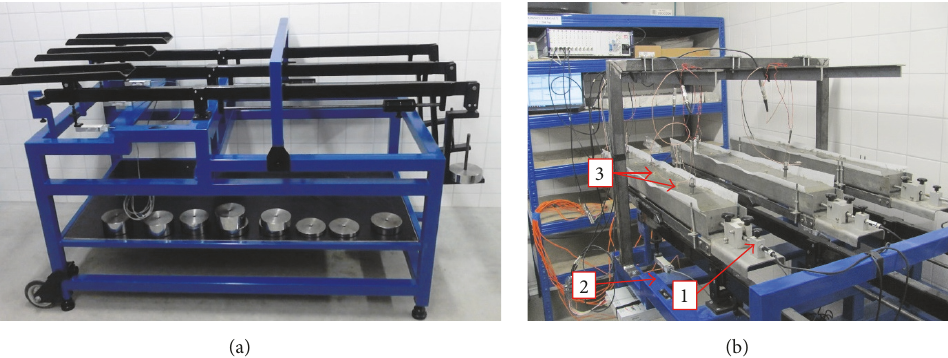
Figure 2: Weighing table for continuous measurement of mass loss (a); shrinkage drains placed on the weighing table (1: shrinkage drain with the inductivity sensor; 2: weighing table; 3: embedded markers).